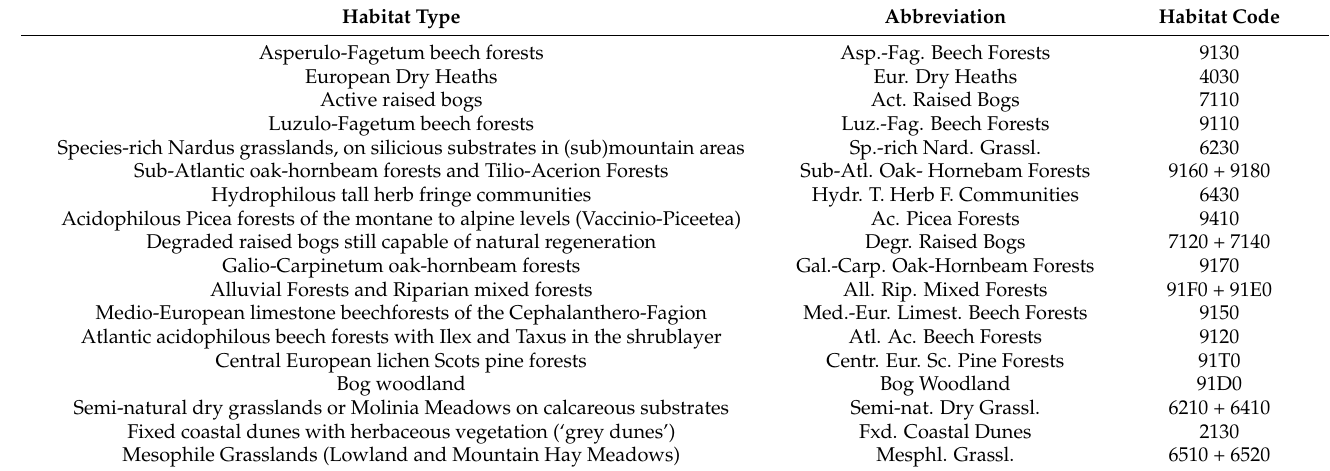
Table A2. List of habitat type abbreviations. Habitat Types as listed in Annex I of the Habitats Directive are provided with a unique code, which is also referred to here.